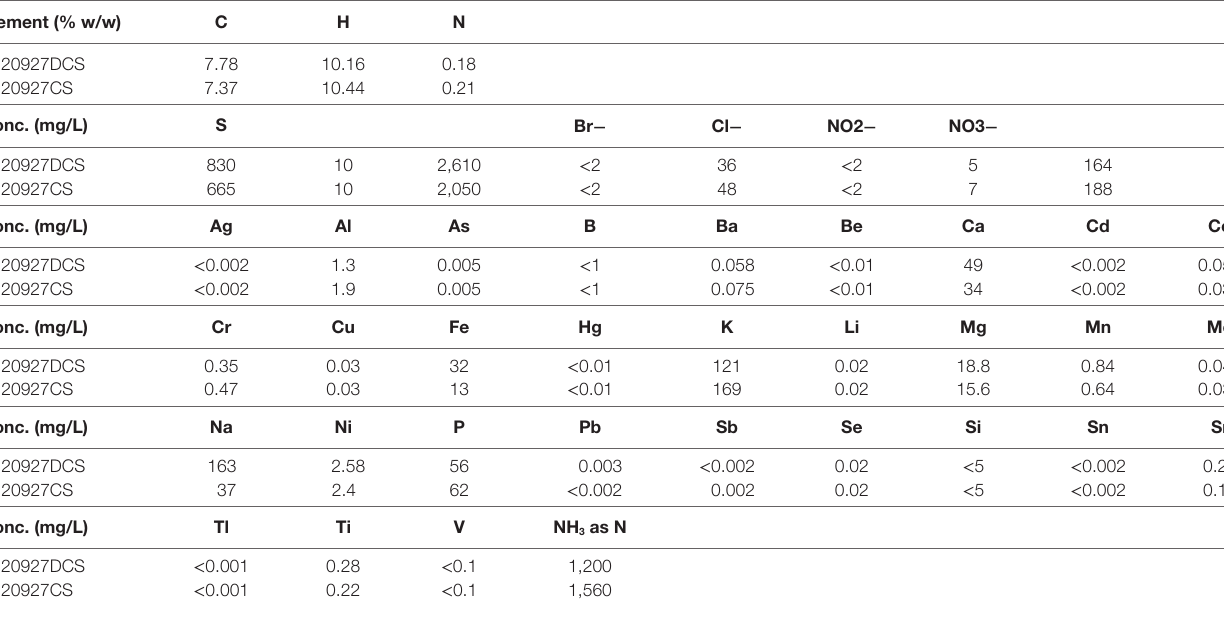
TaBle 1 | Analysis of saccharified slurries using high-performance liquid chromatography (HPLC), GC-MS, and LC-DAD-MS. TaBle 2 | The composition of the two saccharified slurries of non-deacetylated (P120927CS) and deacetylated (P120927DCS) corn stover analyzed by inductively coupled plasma mass spectrometry. element (% w/w)